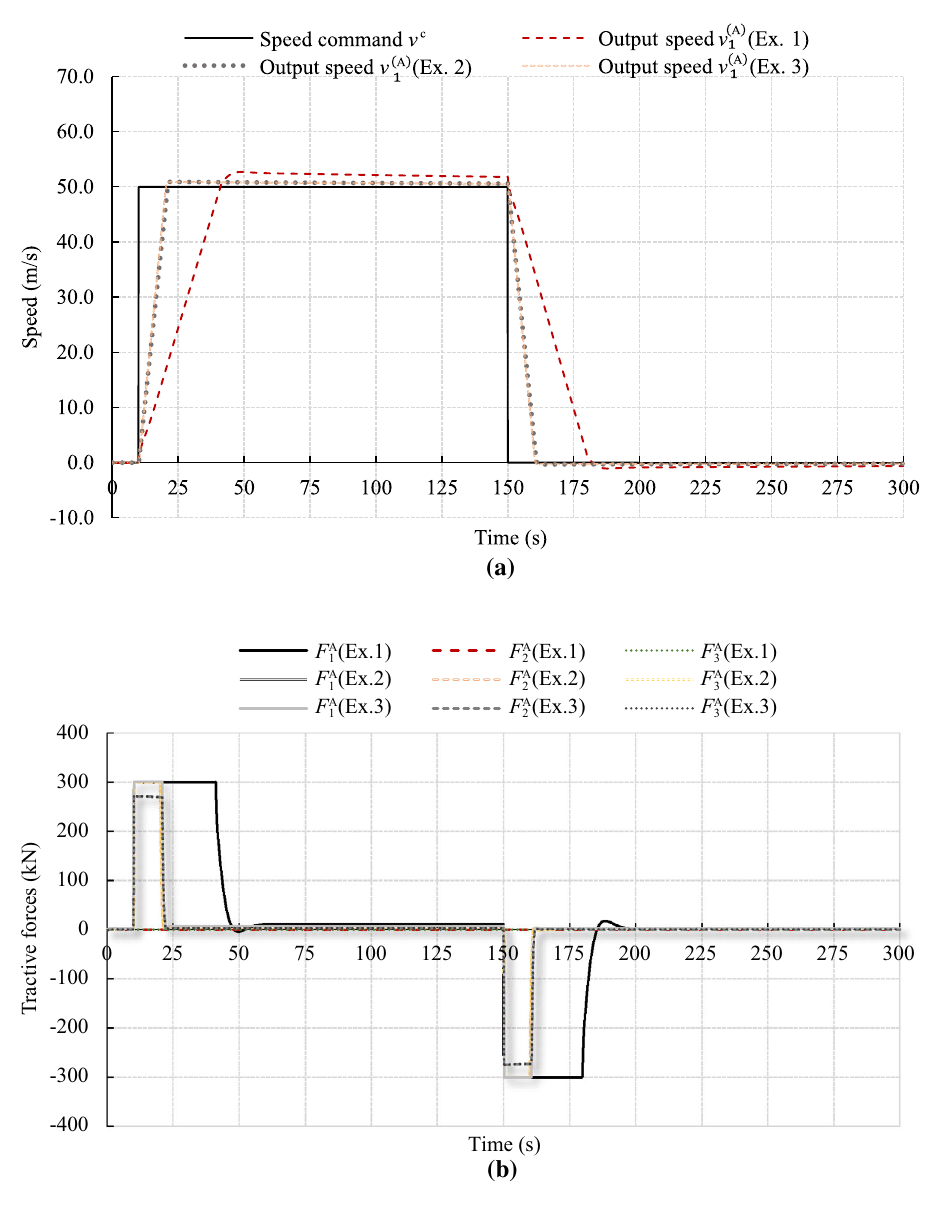
Fig. 6 Numerical results based on the LTD for model A of the MUT: a train speed _ x 1 vs. time; b tractive forces F A passive vibration damping is only used; in Ex. 3 both passive and active vibration damping are